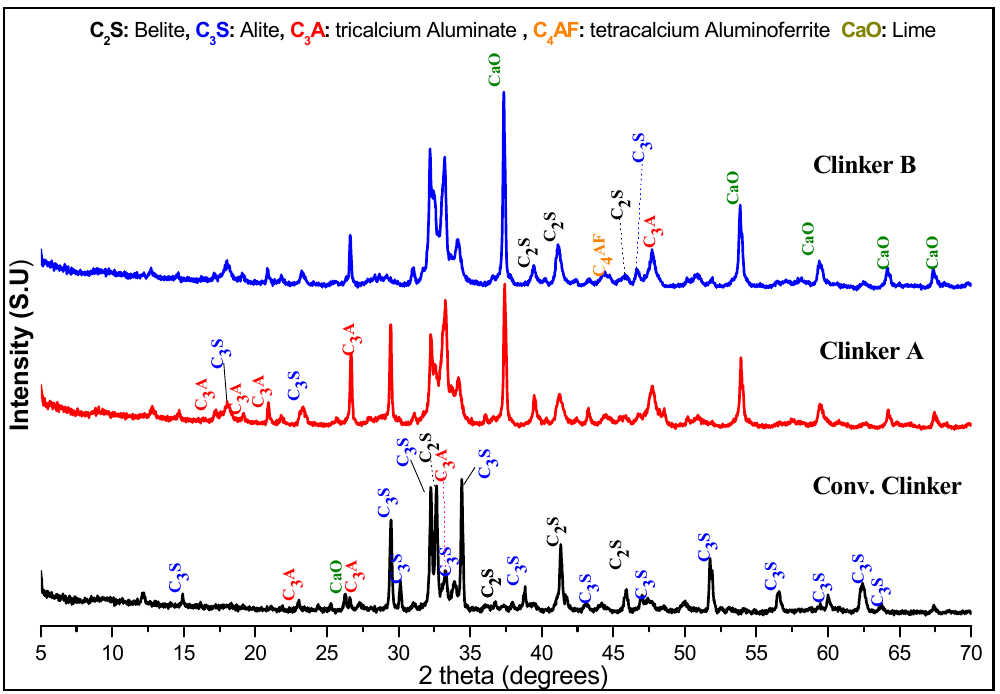
Figure 9. X-ray di ff raction patterns of clinker A and B produced by mechanosynthesis versus Figure 9. X-ray diffraction patterns of clinker A and B produced by mechanosynthesis versus conventional conventional clinker.